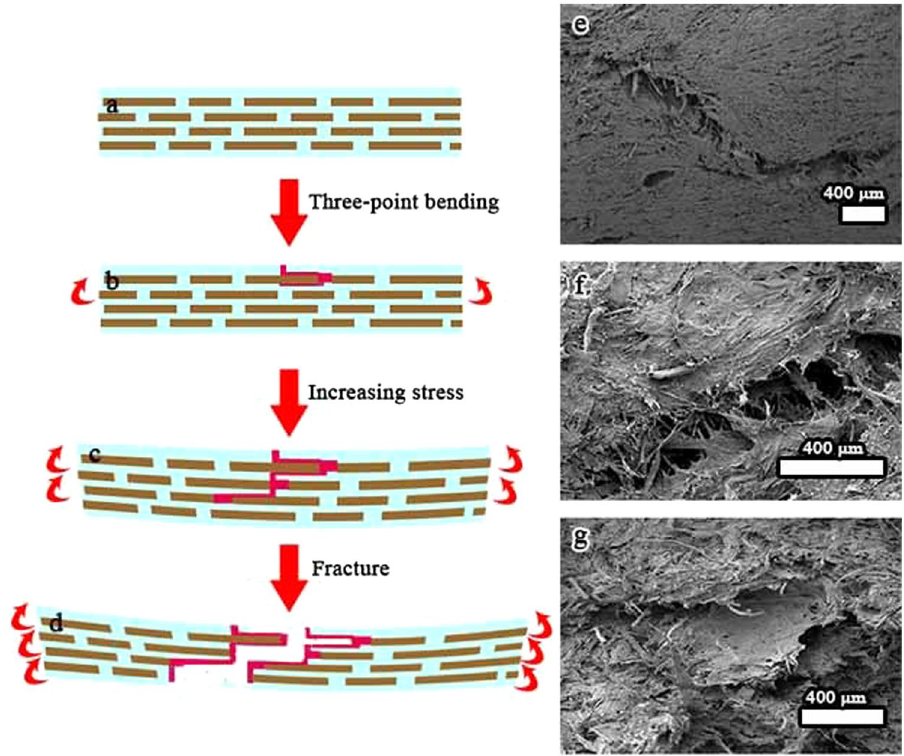
Figure 6. ( a – d ) Proposed synergistic mechanism of 2D NLC platelets. ( a ) Simplified structural schematics, showing the alternate arrangement of2D NLC platelets. ( b ) Under three-point bending, the NLC platelet starts to slide and deflect crack, ( c ) activates thepotential sliding of adjacent multiple NLC platelets. ( d ) The composite finally fails under NLC platelets facture mode. ( e – g ) Fracture morphology of the nacre-like composite, ( e ) crack deflection between layers and crack branching, ( f ) crack bridging, ( g ) NLC platelets’ fracture